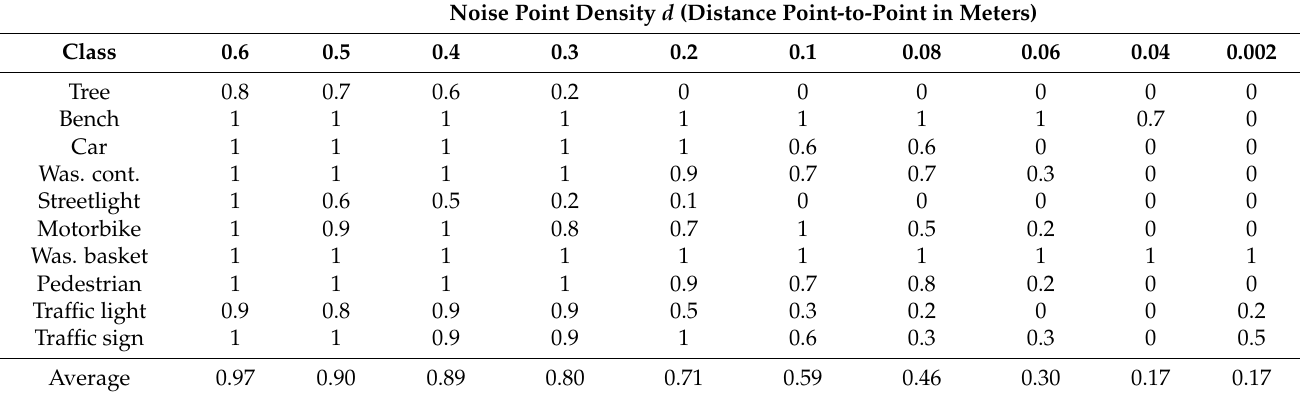
Table 6. Precision of classification with different levels of noise.